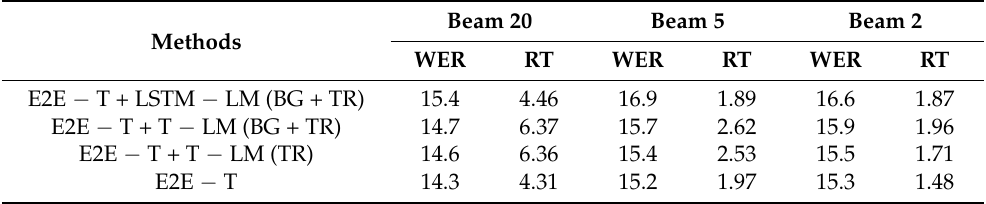
Table 6. The E2E − T Transformer and LM rescoring setups were compared (WER % and RT factor). Transcription (TR) and background (BG) texts were used to train the language models. Beam 20 Beam 5 Beam 2 Methods